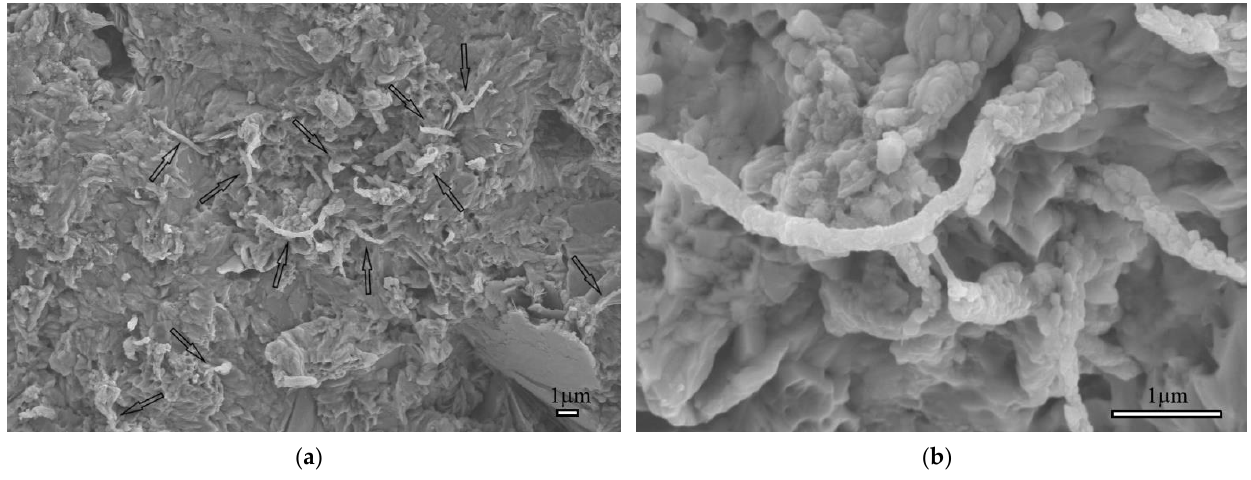
Figure 4. Microstructural characteristics of the cement matrix blended with NS-N66 NFs at low and high magnification (the arrows denote the fiber locations inside the cement matrix)